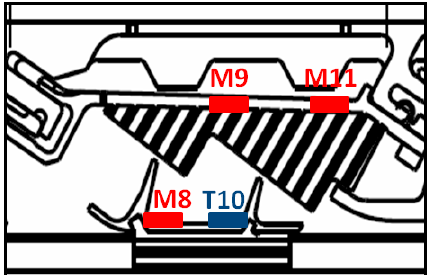
Figure 15. Thermocouples placed in the seal region.